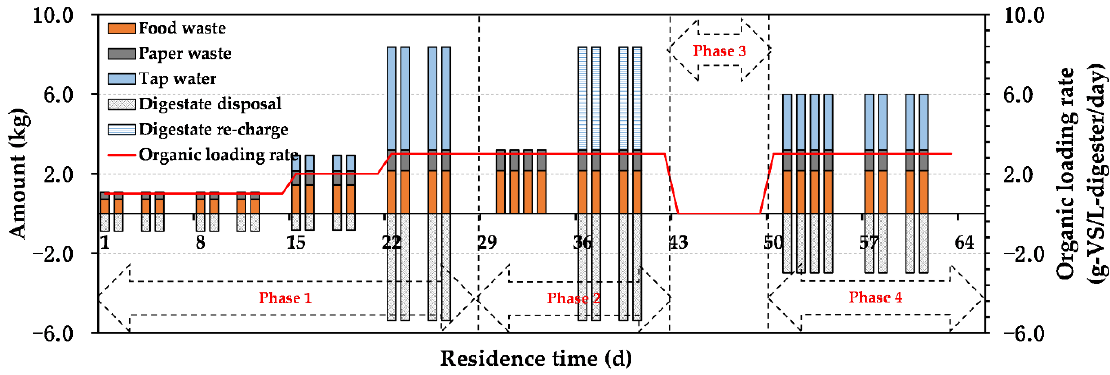
Figure 2. Materials charging plan and operating factors of this study.